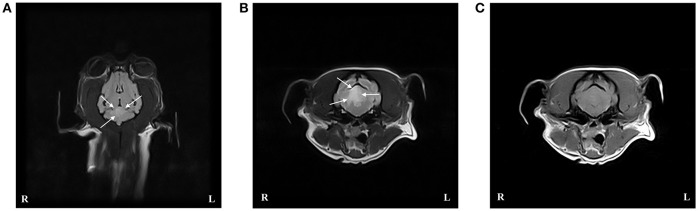
Case 3 T2-weighted (T2W) FLAIR dorsal image of the brain (A), and T2W (B), and T1-weighted (T1W) post contrast (C) transverse images at the level of the caudal cerebellar peduncles revealed an intra-axial well demarcated lesion to the right of the midline consistent with an ischemic stroke affecting the right rostral cerebellar artery. The lesion (indicated by arrows) is hyperintense compared to normal gray matter on T2W sequences and hypo- to isointense on T1W sequences.